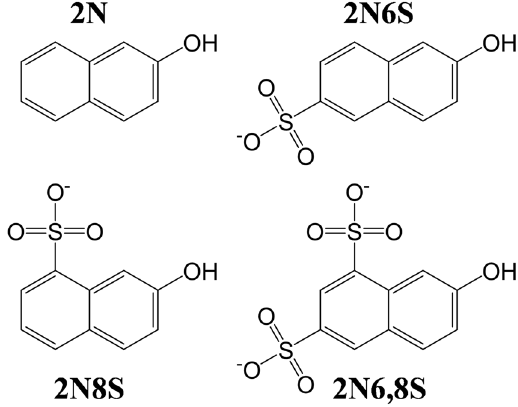
Figure 1. Molecular structure of 2N, 2N6S, 2N8S and